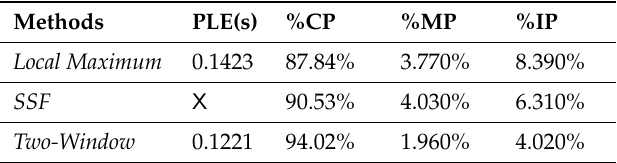
Table 2. The average peak detection